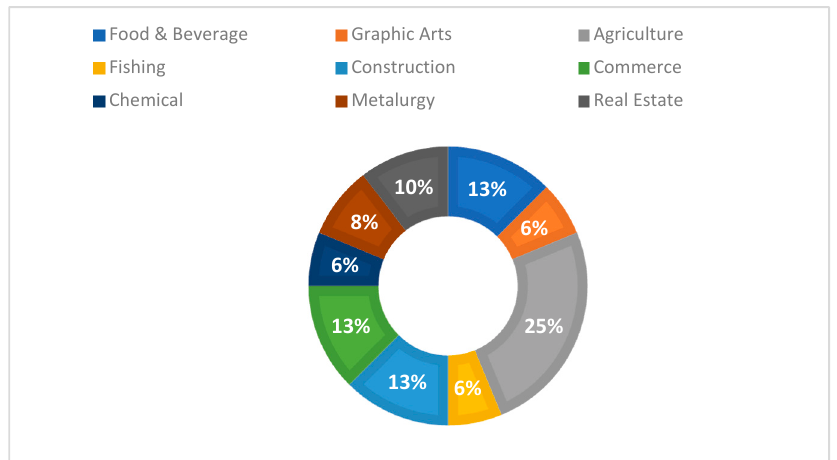
Figure 4. Distribution of companies by revenue.